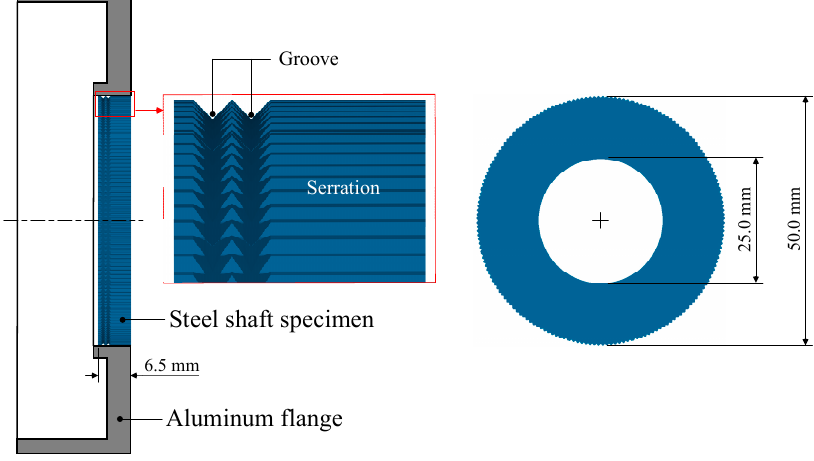
Figure 3. SCr420 inner part for joining.